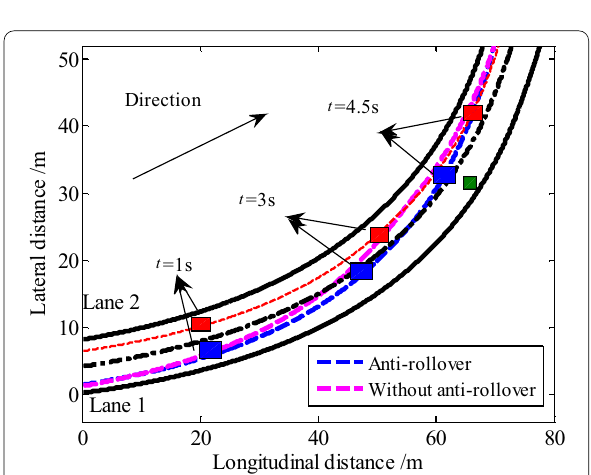
Figure 10 Vehicles’ trajectories in Scenario 2